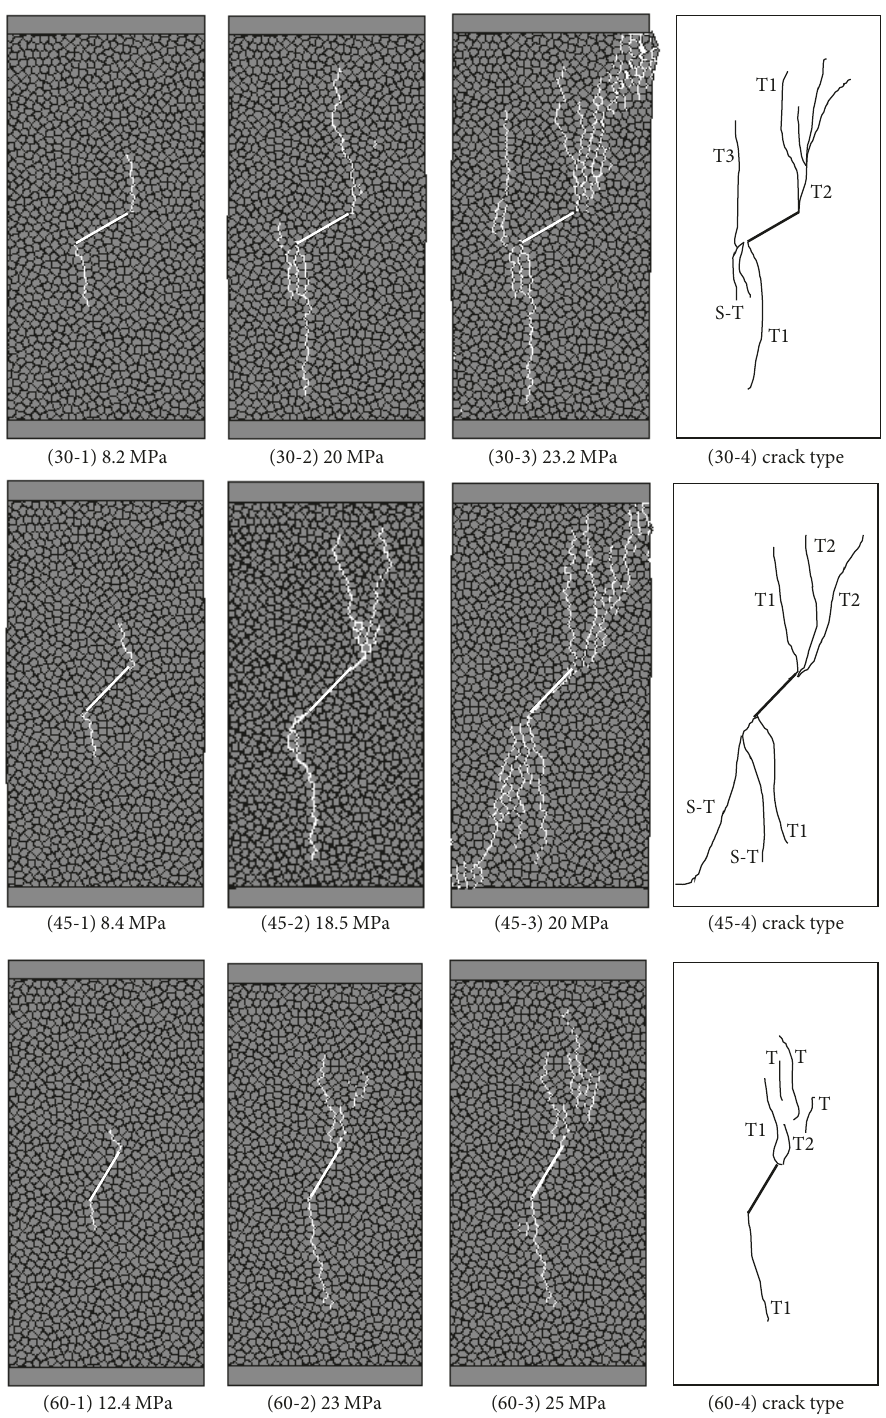
Figure 15: The failures modes at different inclination angles ( 𝛽 ). Length of the preexisting flaws is 20 mm. T: tensile crack, S: shear crack, and the number represents crack